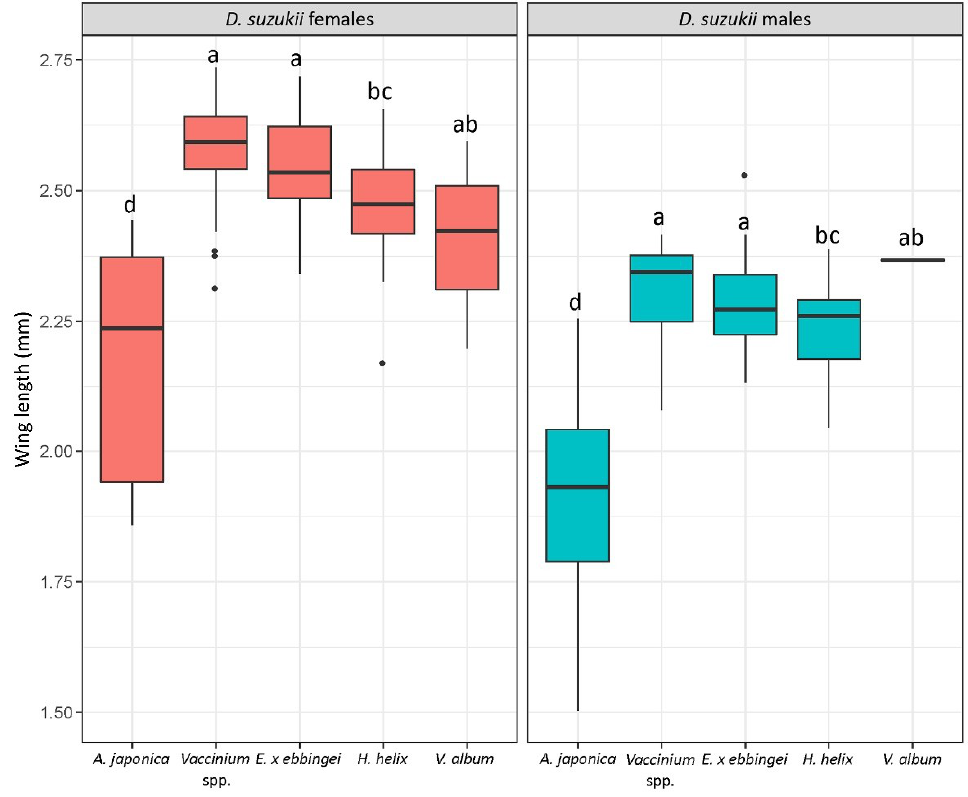
Figure 5. Wing length of D. suzukii adults emerged from the same above-mentioned fruits. Letters indicate statistical differences ( p < 0.05) after Tukey’s multiple comparison test.